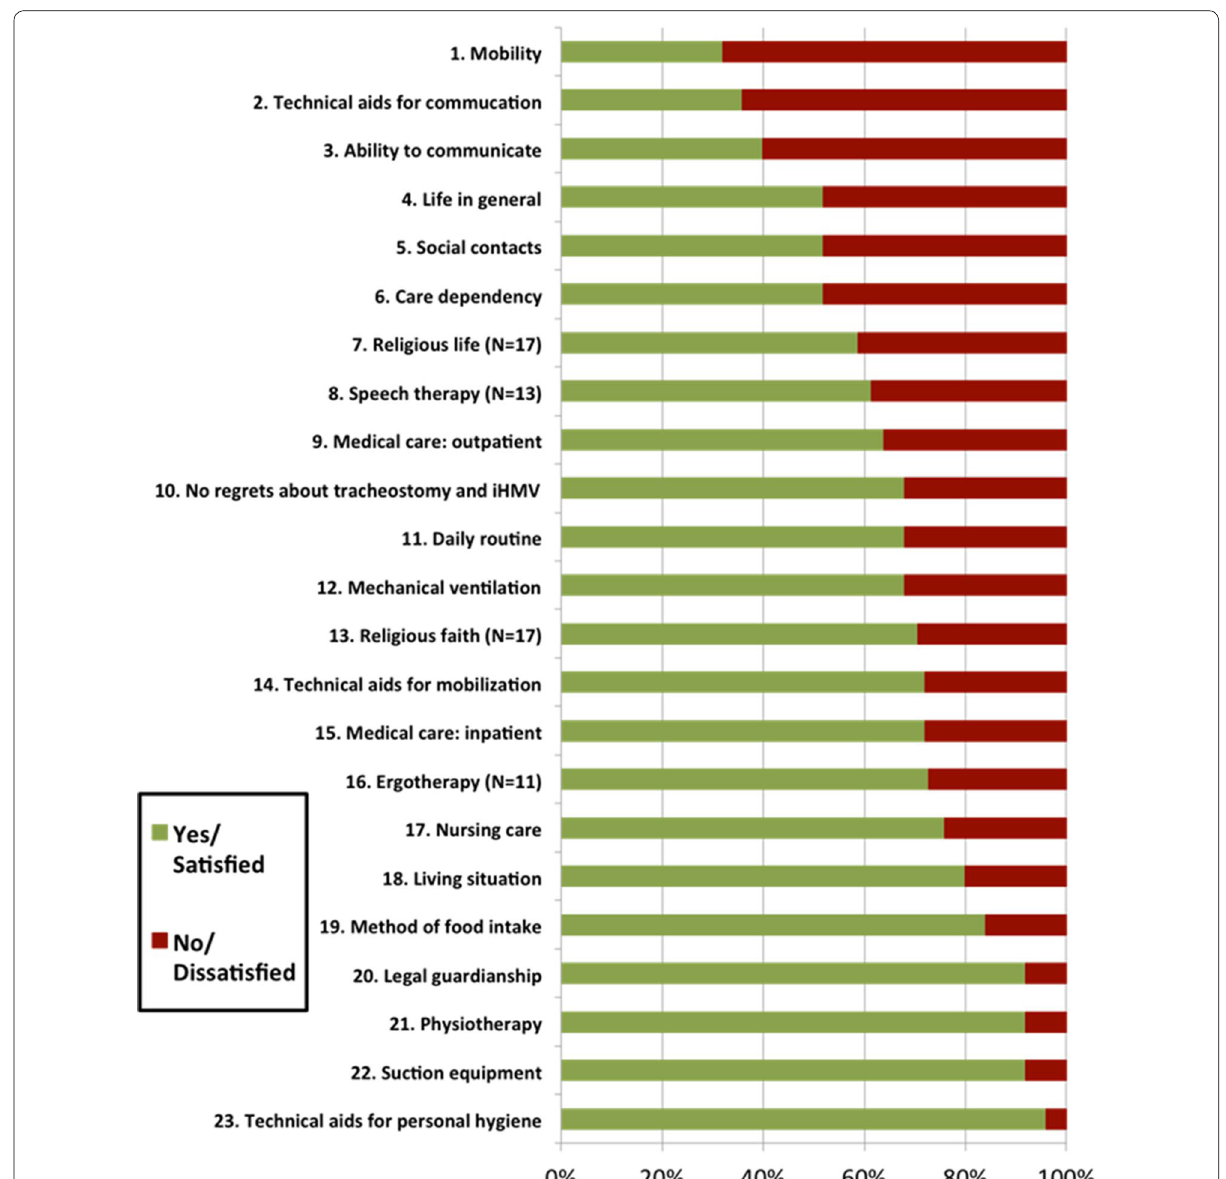
Fig. 2 Subjective evaluation of life satisfaction in relation to 23 specific aspects of life in ascending order. iHMV invasive home mechanical ventila-